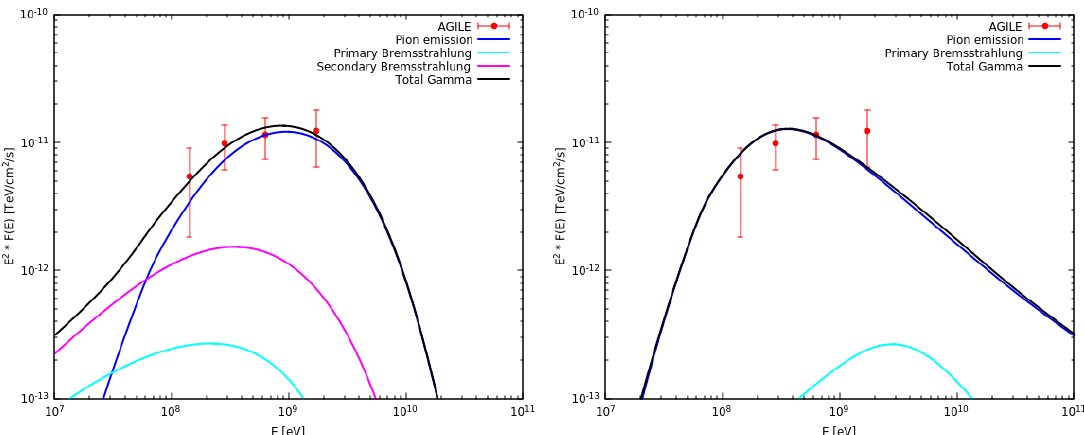
Figure 4. Left: AGILE (red) γ -ray points plotted with the different contributions estimated in our re-acceleration model: γ -ray emission from pion decay (blue line), primary and secondary Bremsstrahlung (cyan dashed line and magenta dashed line, respectively), and total emission (black line). Right: the same data and model curves are shown in the left panel but assuming that only adiabatic compression is present. Figures from